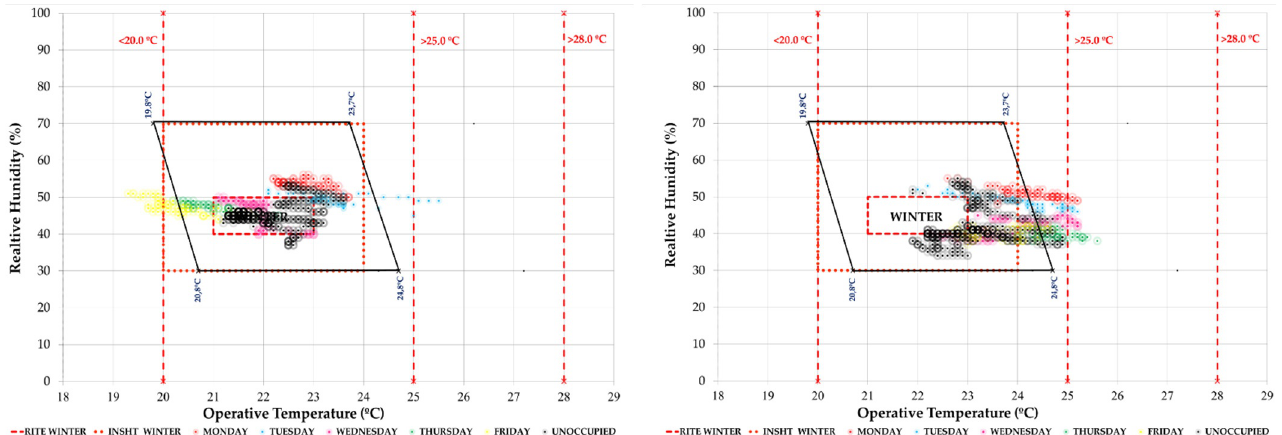
Figure 21. Indoor thermal comfort during the week of 26 April 2021 to 2 May 2021 (Phase II) in classroom A 1.1 ( left ) and classroom A 2.1 ( right ). Source: authors.